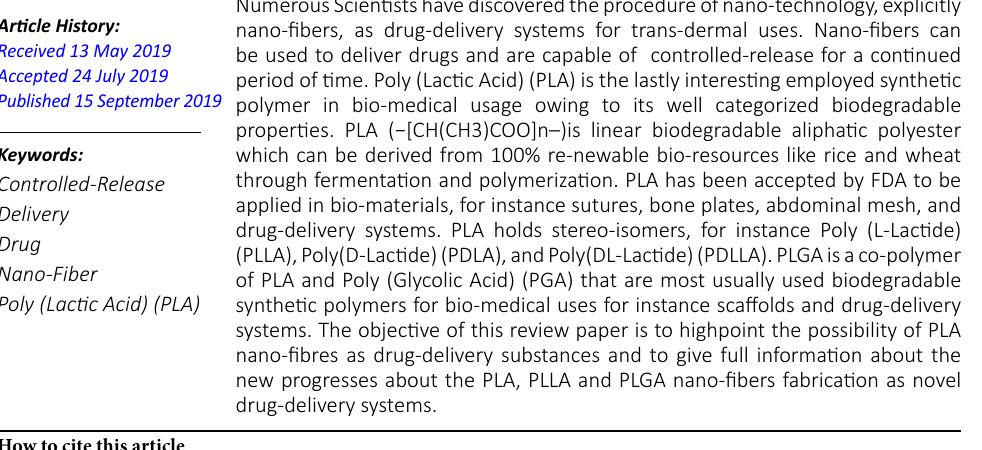
Fig. 1 signifies the standard electro-spinning method used to create drug-delivery